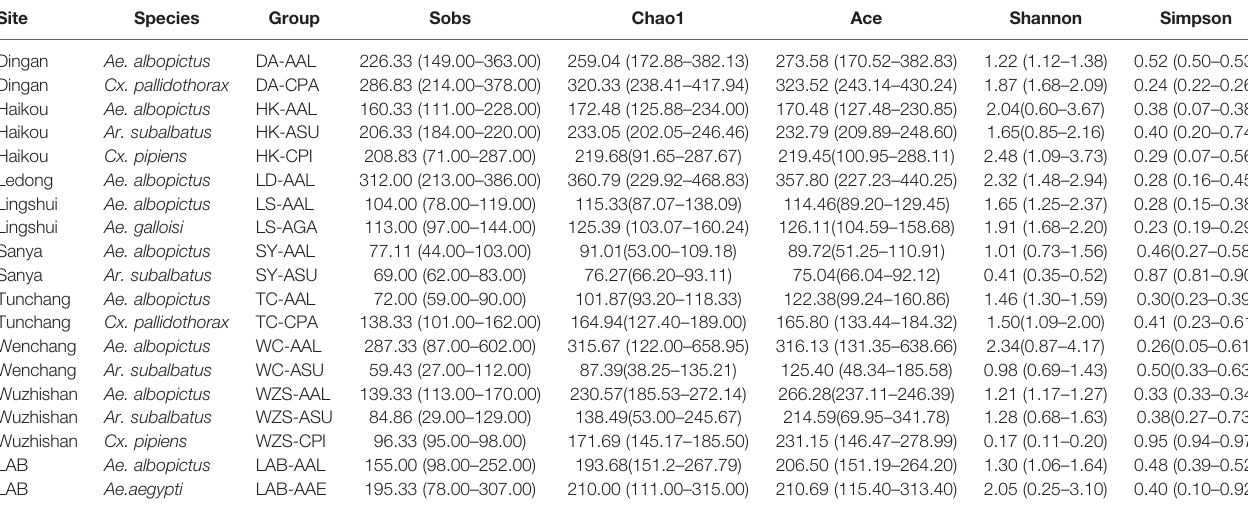
TABLE 2 | Diversity and richness (mean and 95% con fi dence limits) of the midgut bacterial communities of six mosquito species from eight sites in Hainan